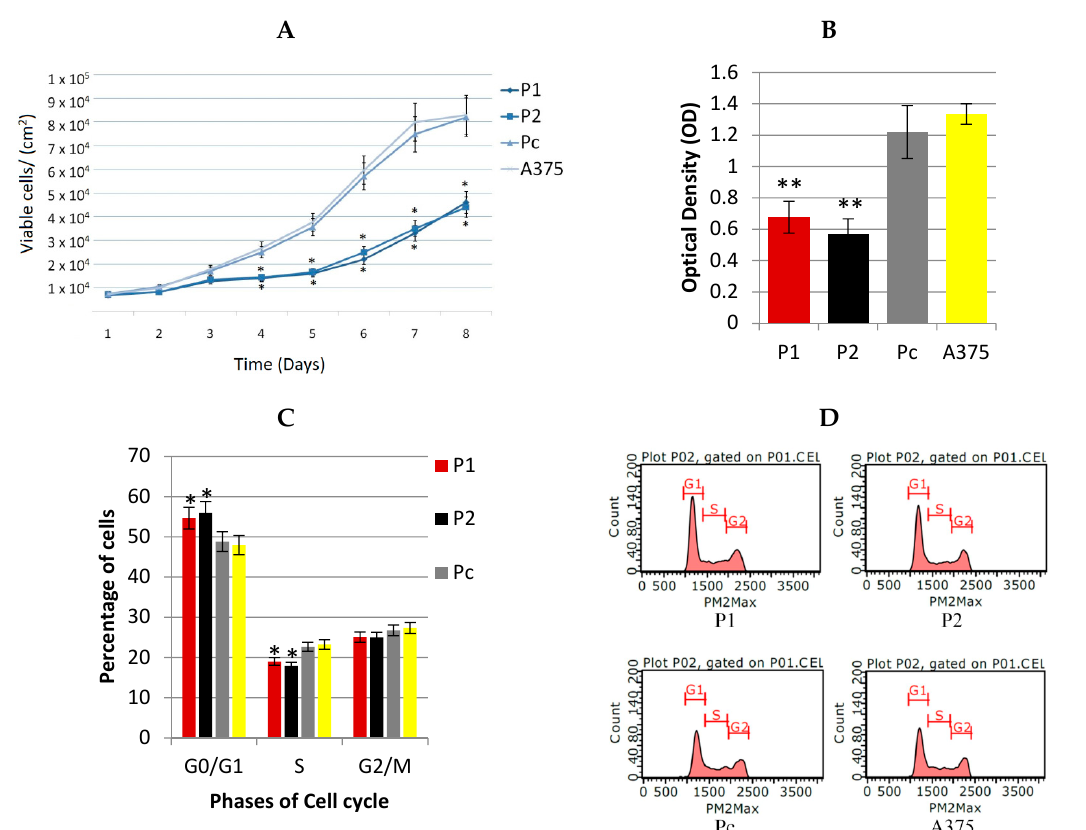
Figure 5. Anti-proliferative effects of YB-1 shRNA ( A ) Colorimetric MTT assay performed by measuring the value of optical density at a wavelength of 590 nm with a reference filter of 620 nm by TECAN Infiniti plate reader; ( B ) Serial cell counting for different cell strains to detect the pattern of exponential cell growth by trypan blue stain; ( C , D ) Flow cytometry cell cycle analysis of the different cell strains to detect any interference by YB-1 shRNA by Guava easyCyte flow-cytometer. All the quantitative results were presented as means ± standard error compared with Pc cell strain and analyzed using one-way ANOVA, * p < 0.05, ** p < 0.001.